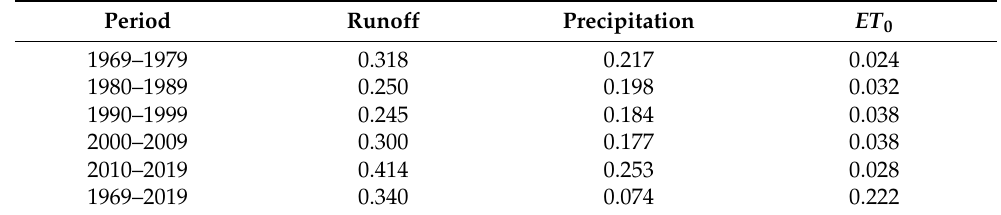
Table 1. The variation coefficient of hydrological and meteorological elements in the past 50 years.